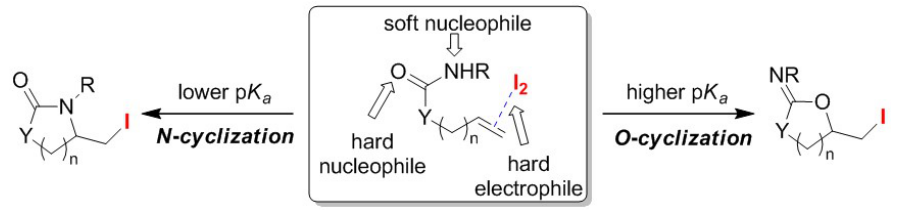
Figure 10. HSAB control in the O / N atom-selective cyclization of amphoteric nucleophiles.